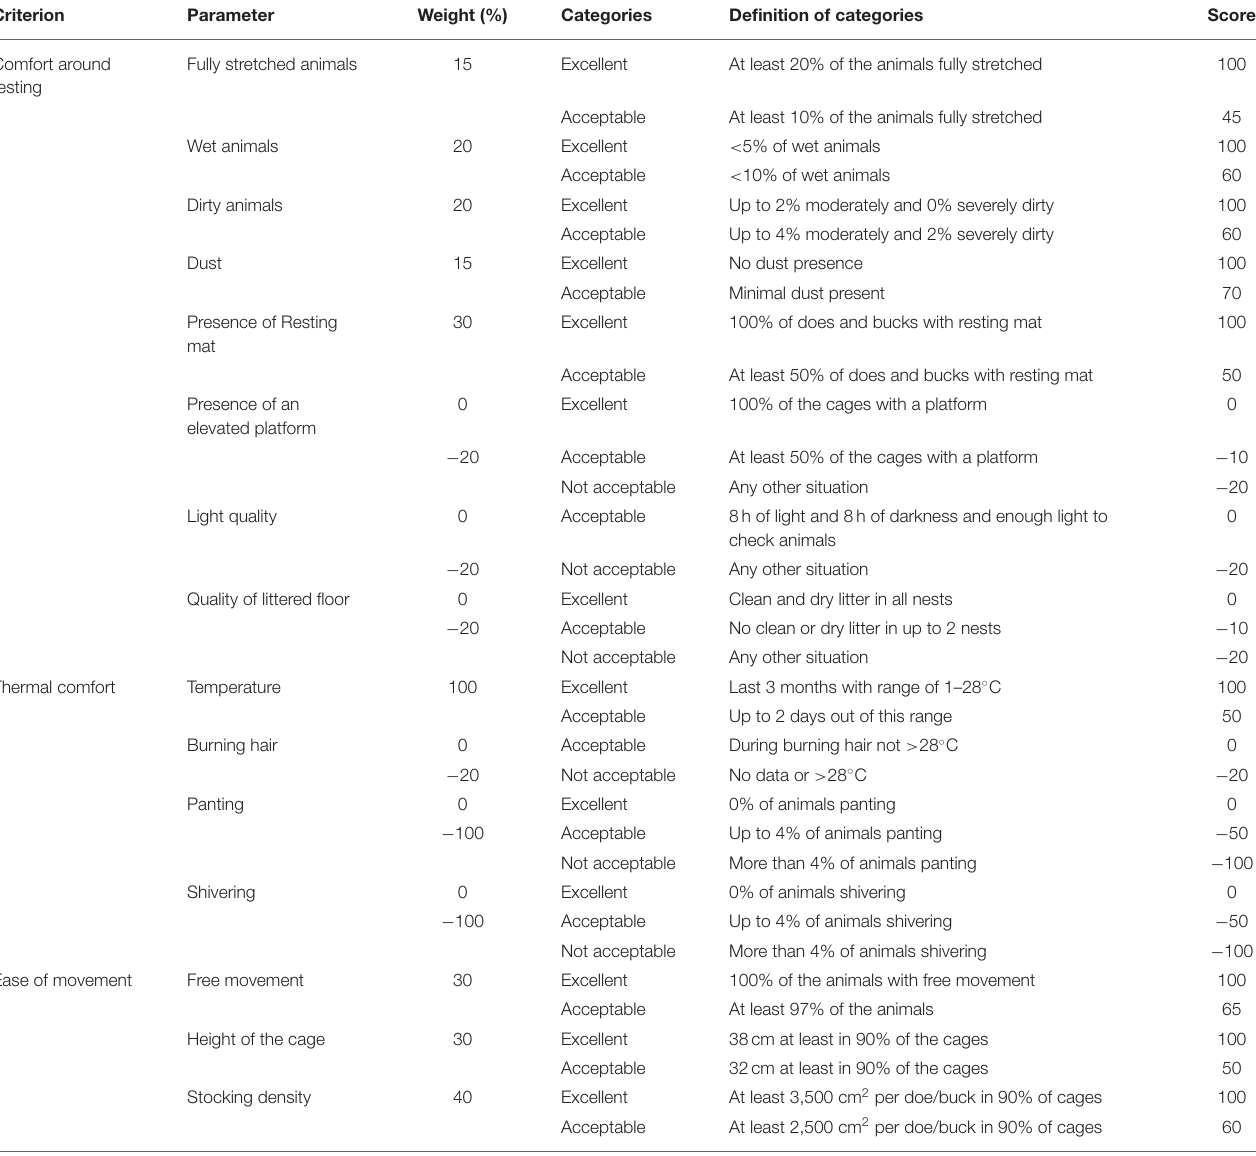
TABLE 3 | Parameters used to assess the criteria of comfort around resting, thermal comfort, and ease of movement.